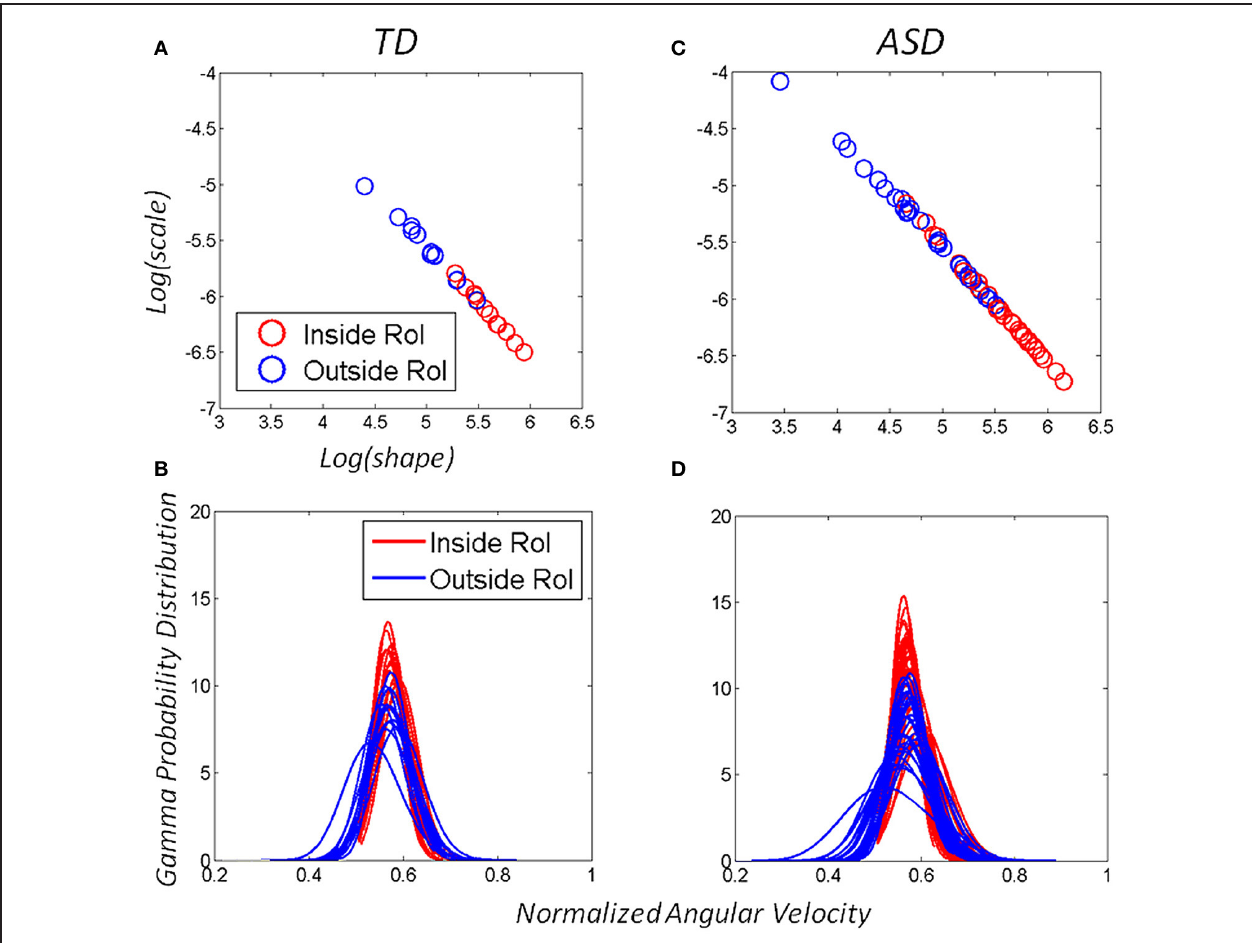
the space in search for the vRoI and as it discovered it and the hand was held there continuously to sustain the media playing. (A) Patterns of a TD child. (C) Patterns of a child with ASD. (B–D) The Gamma probability distributions were estimated from the empirical data within the range of normalized angular velocity values for each child. Note that the child with ASD starts out with higher dispersion in the distribution (variance to mean ratio) but as the vRoI is discovered and the hand sustained inside it, the noise-to-signal ratio decreases, thus increasing the reliability of the probability